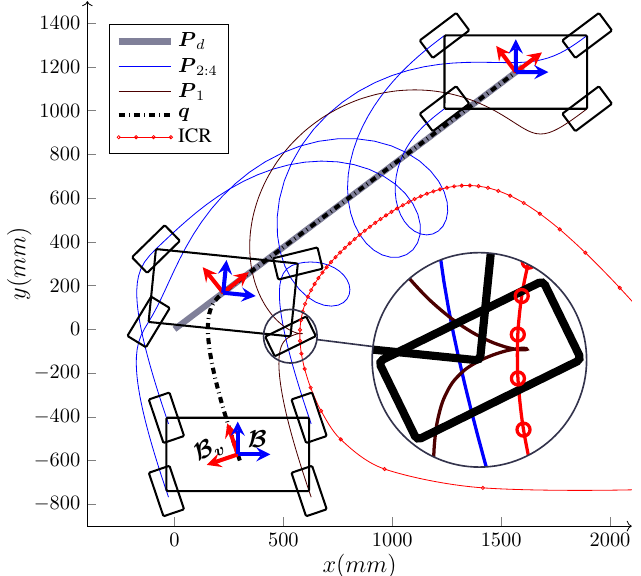
Figure 5. A nonholonomic omnidirectional WMR with four steering wheels following the desired path P ( d ) , which is a straight line, while turning around itself.